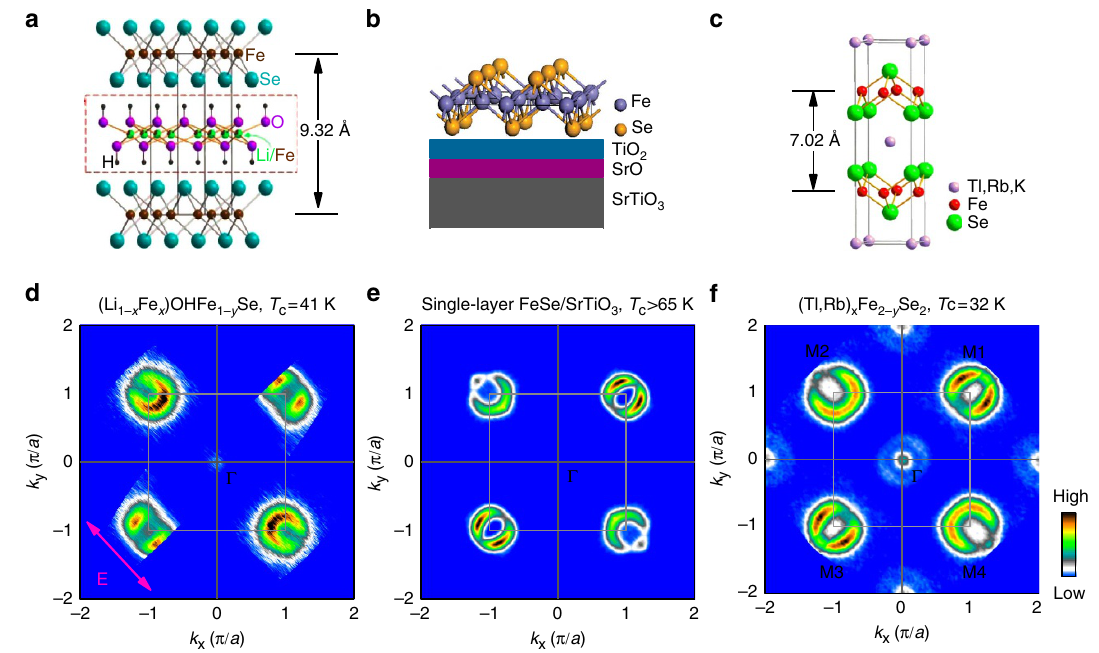
Figure 1 | Crystal structure and Fermi surface of three FeSe-based superconductors. ( a ) The crystal structure of (Li 1 (cid:2) x Fe x )OHFe 1 (cid:2) y Se. The c lattice constant is 9.318Å for optimally doped sample with a T c at 42K (refs 36,39). ( b ) Schematic structure of single-layer FeSe film deposited on a SrTiO 3 substrate 19 . The thickness of the FeSe layer is B 5.5Å. ( c ) Schematic structure of (Tl,Rb) x Fe 2 (cid:2) y Se 2 (ref. 12). The distance of the adjacent FeSe layers is B 7.02Å. ( d ) Fermi surface mapping of (Li 0.84 Fe 0.16 )OHFe 0.98 Se superconductor measured at 20K. The spectral weight distribution was obtained by integrating the measured photoemission spectra (EDCs) within [ (cid:2) 10, þ 10]meV energy window with respect to the Fermi level as a function of k x and k y